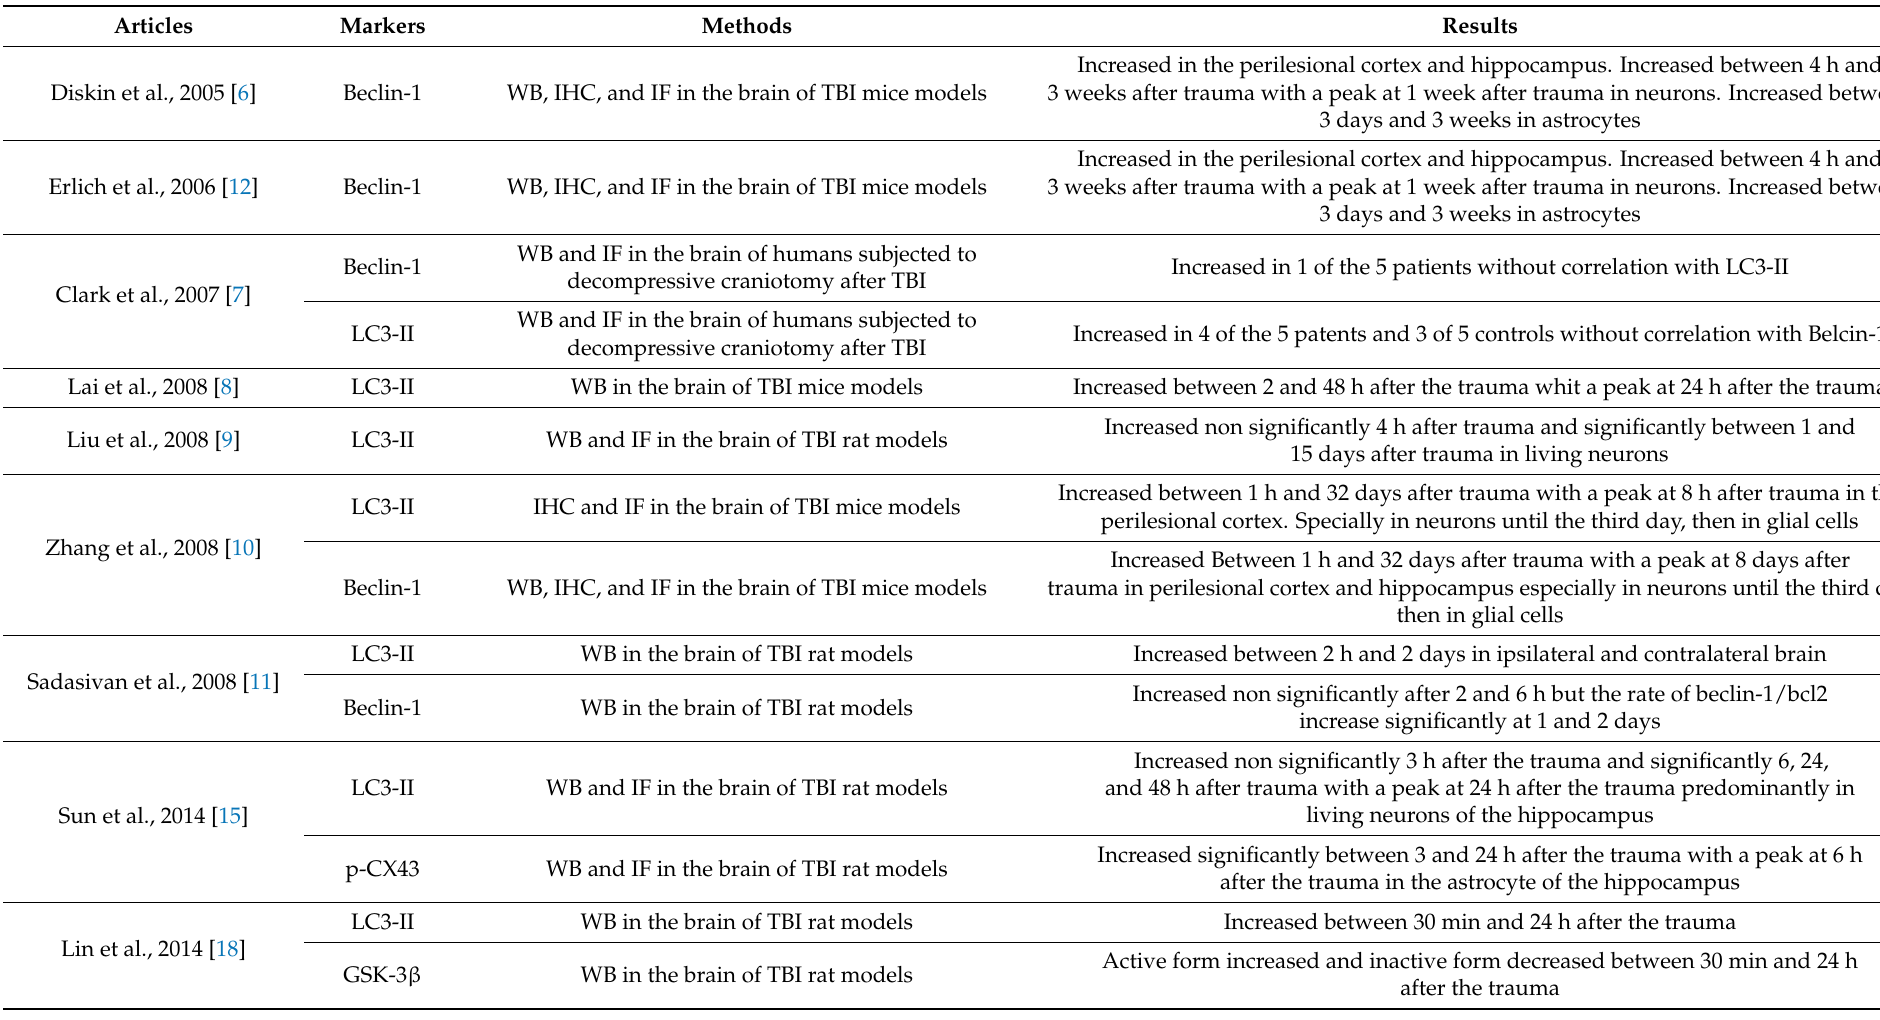
Table 1. Articles included in the